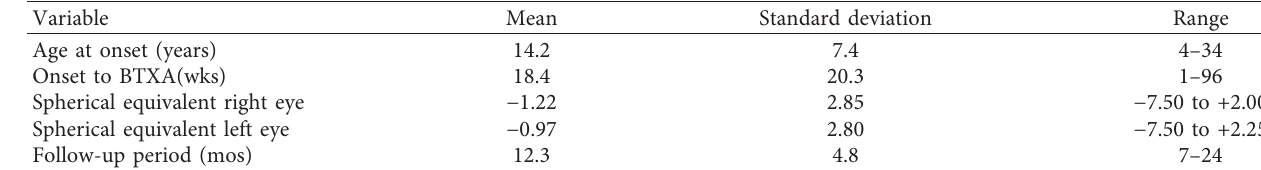
Table 3: Clinical profile of study population.